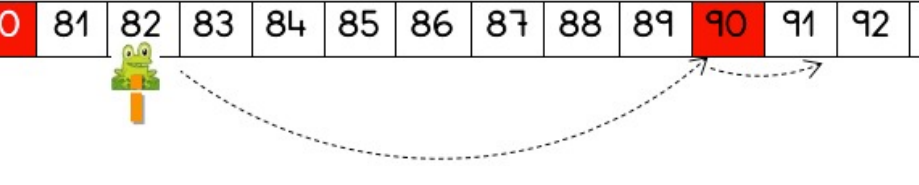
Figure 30. Saltarina is in 82 and jumps 9.